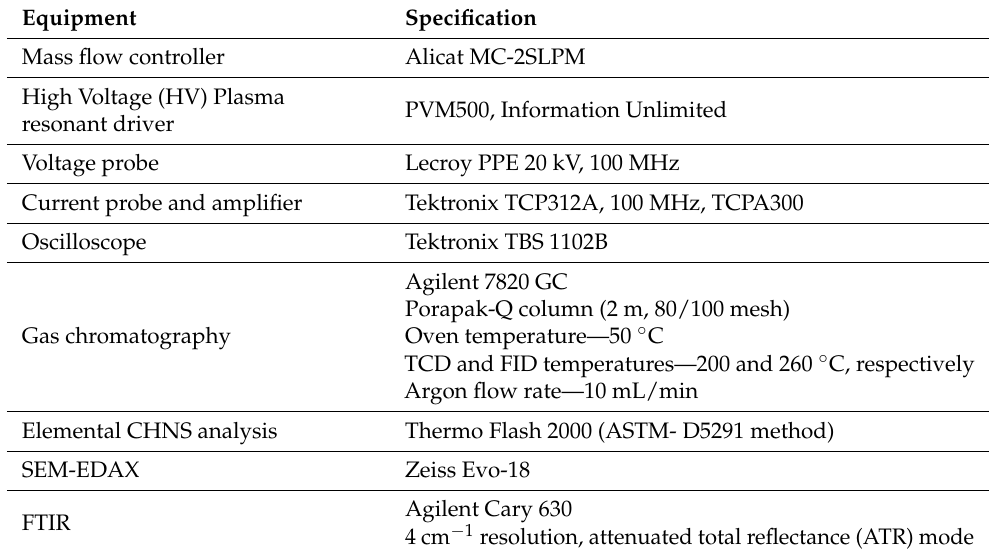
Table 2. Details of the equipments and analytical facilies used in this